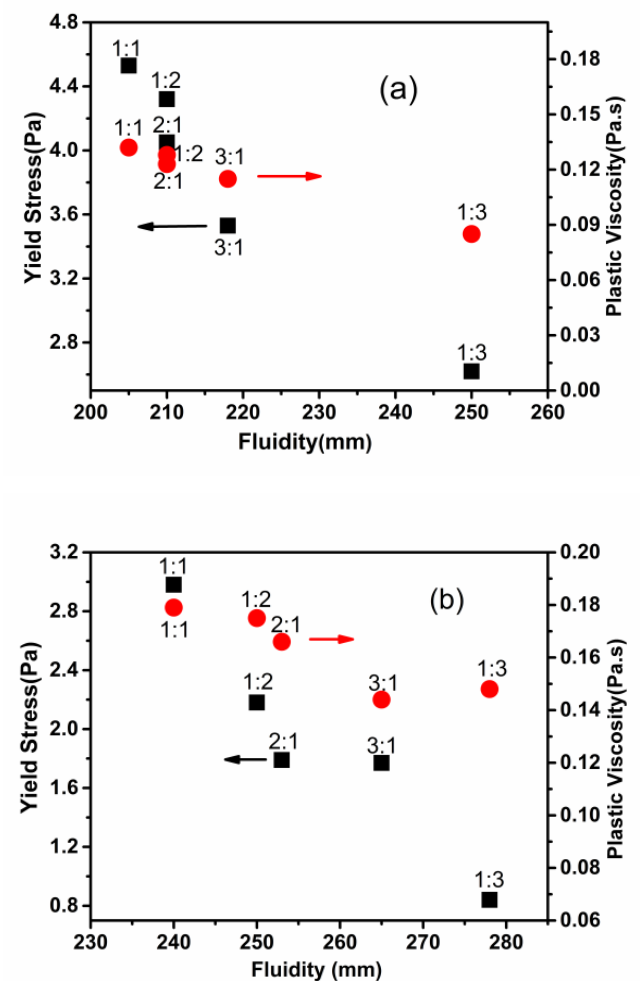
Figure 6. Correlations between rheological parameters and fluidity: ( a ) 5 min, ( b ) 90 min. Black square represents yield stress. Red circle represents plastic viscosity.